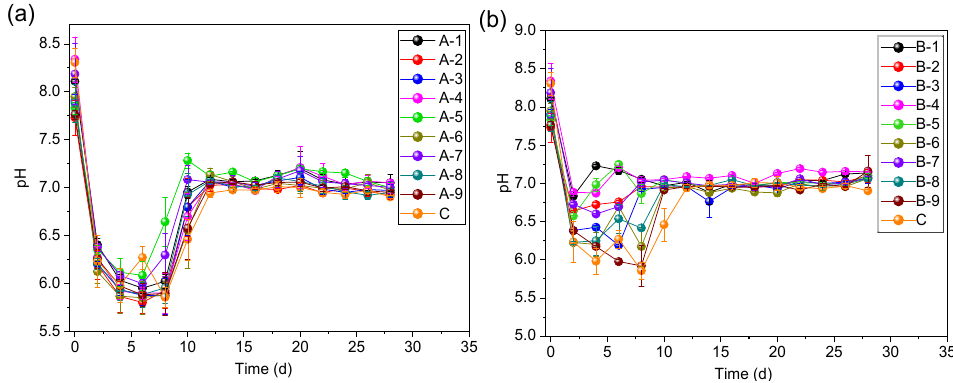
Figure 4. Changes in the pH value of corn stalk during anaerobic fermentation with ( a ) CABC and ( b ) PABC as supplement.